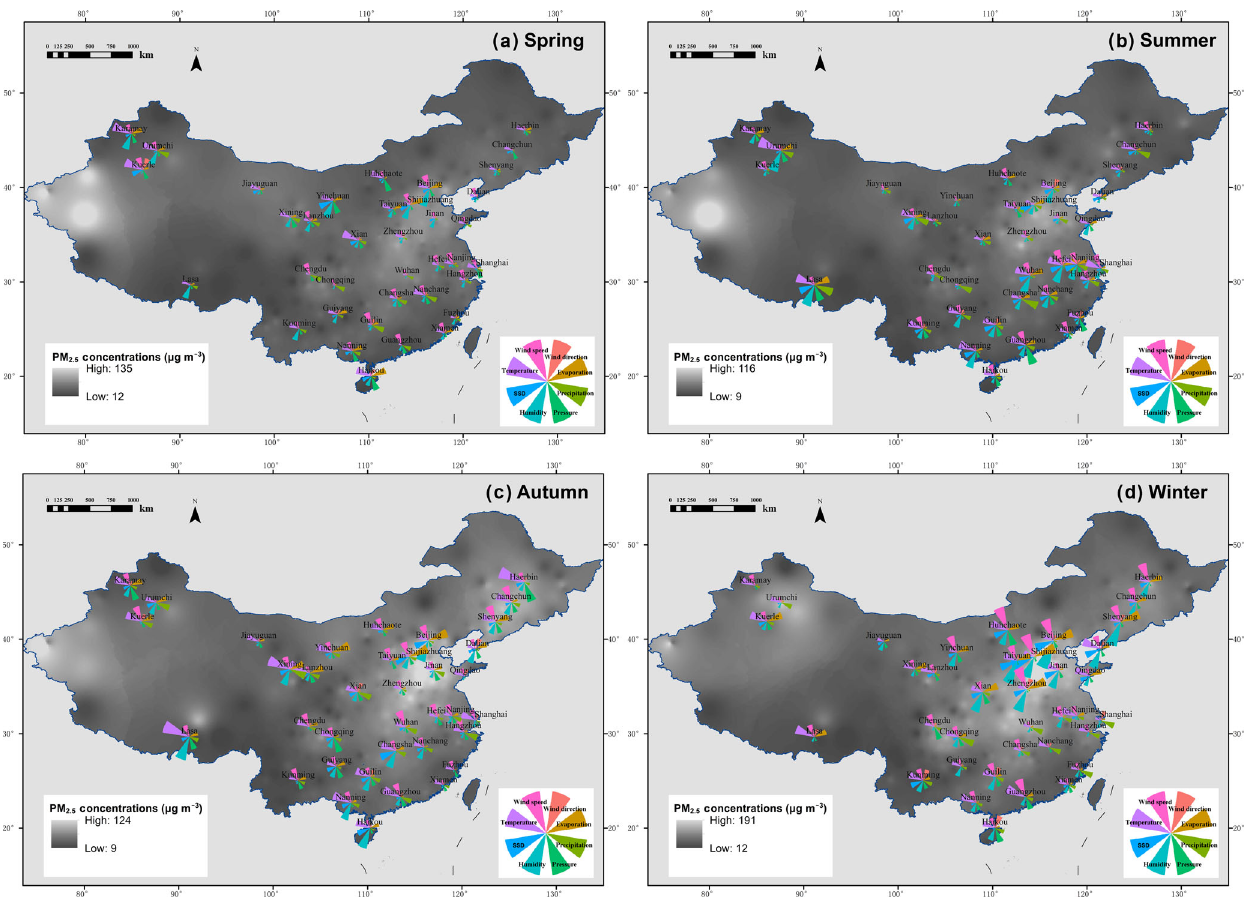
Figure 2. Wind rose map of influences of eight individual meteorological factors on PM 2 . 5 concentrations across mainland China (37 representative cities) during 2014–2016. Table 1. Major meteorological influencing factors for PM 2 . 5 concentrations in four mega-cities within different